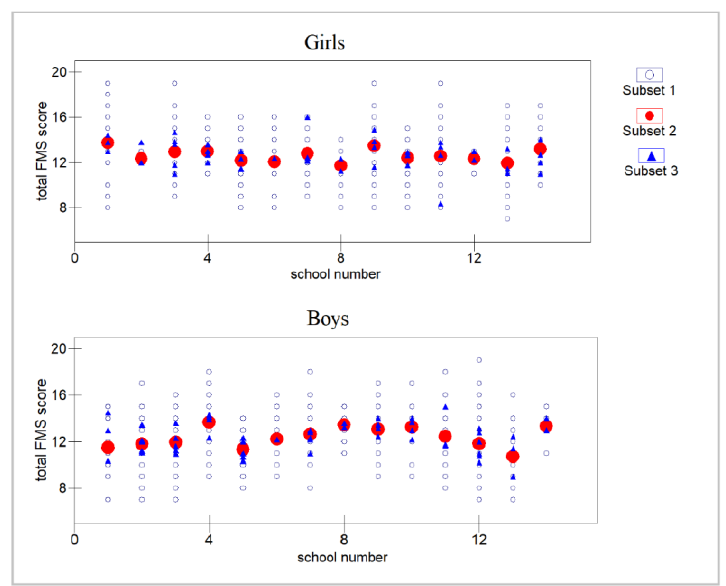
Figure A1. Total FMS score represented for each class and school (each school is represented with different number). Note: subset 1: students; subset 2: classes; Subset 3: schools.